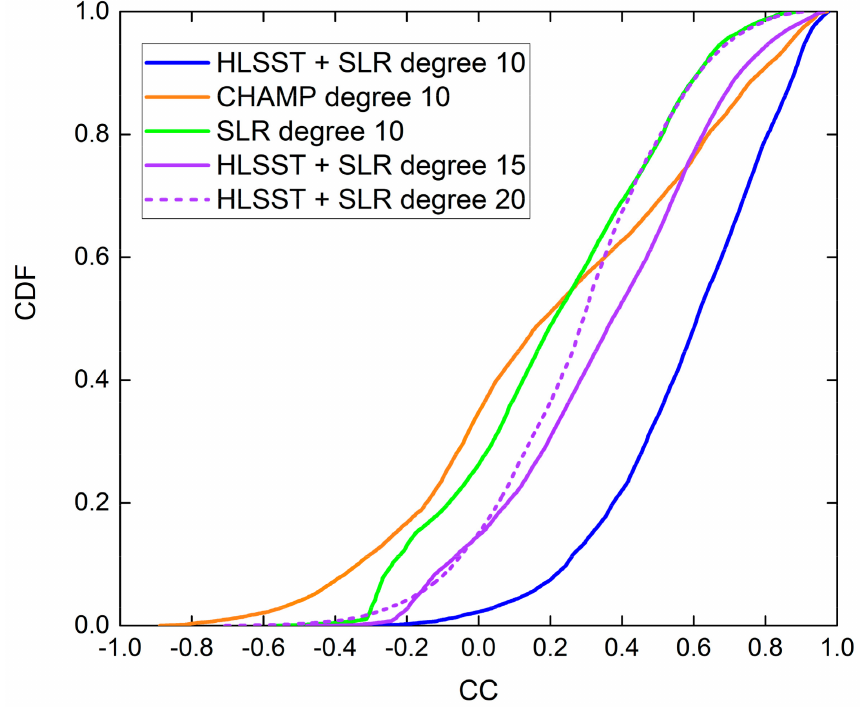
Figure 8. CDF of spatial correlations derived from HLSST+SLR, CHAMP, SLR solutions with GRACE CSR. CC stands for coefficient